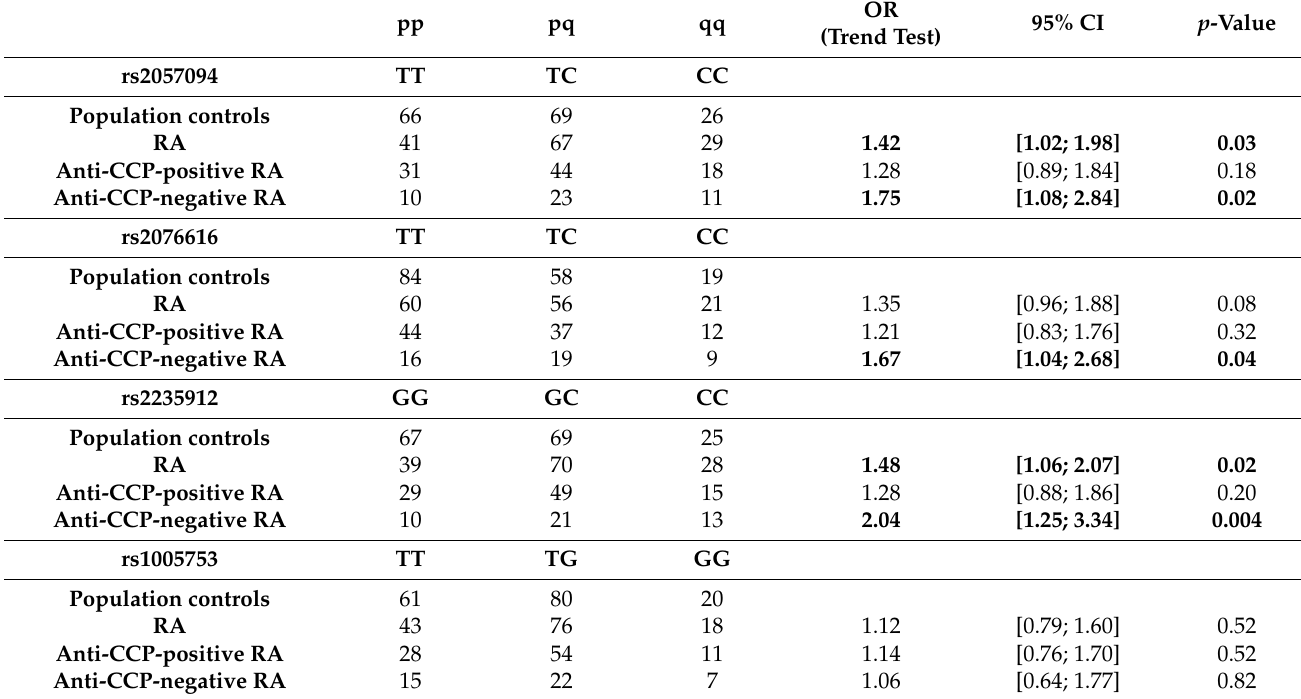
Table 2. Associations between polymorphisms in the peptidylarginine deiminase 2 gene ( PADI2 ) and rheumatoid arthritis (RA), in general ( n = 137), anti-CCP-positive RA ( n = 93) or anti-CCP-negative RA ( n = 44) in particular, in subjects with self-reported periodontitis ( n = 298). pp pq